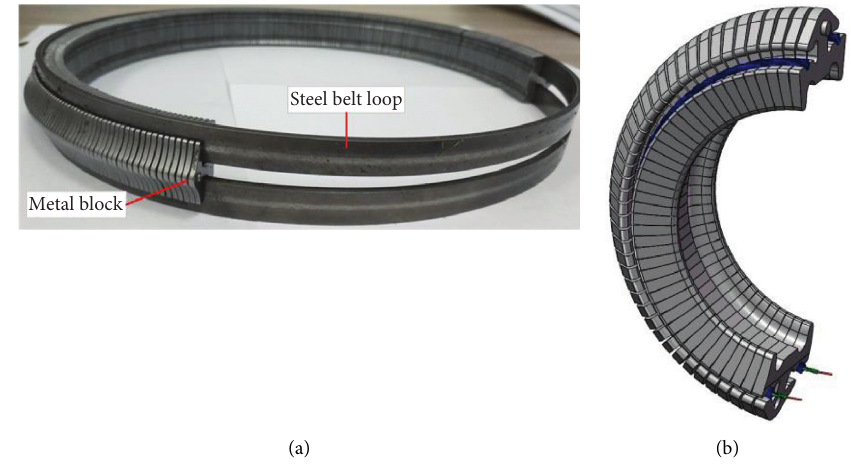
Figure 3: (a, b) MB-CVT steel belt and WR-CVT steel